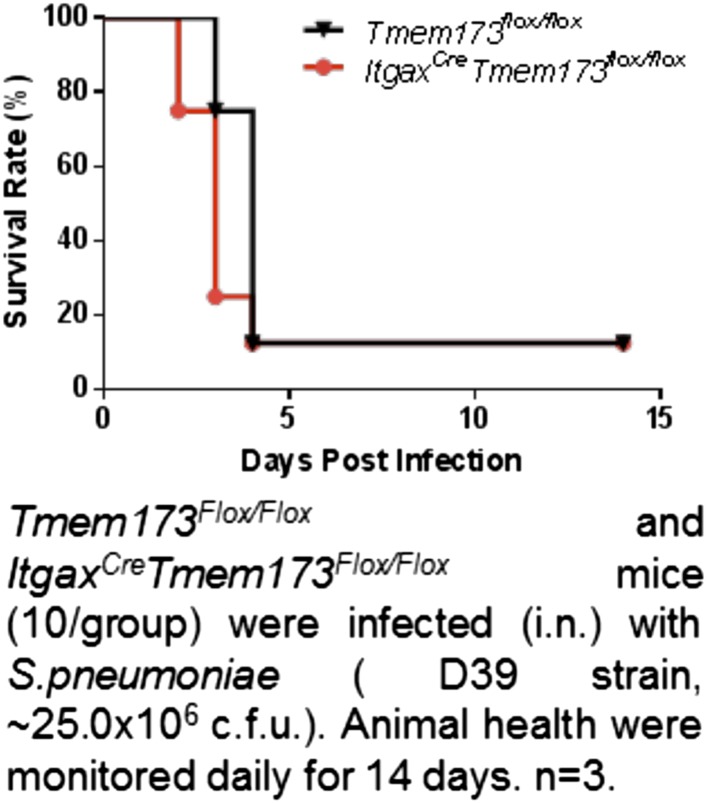
DOI:
http://dx.doi.org/10.7554/eLife.06670.019